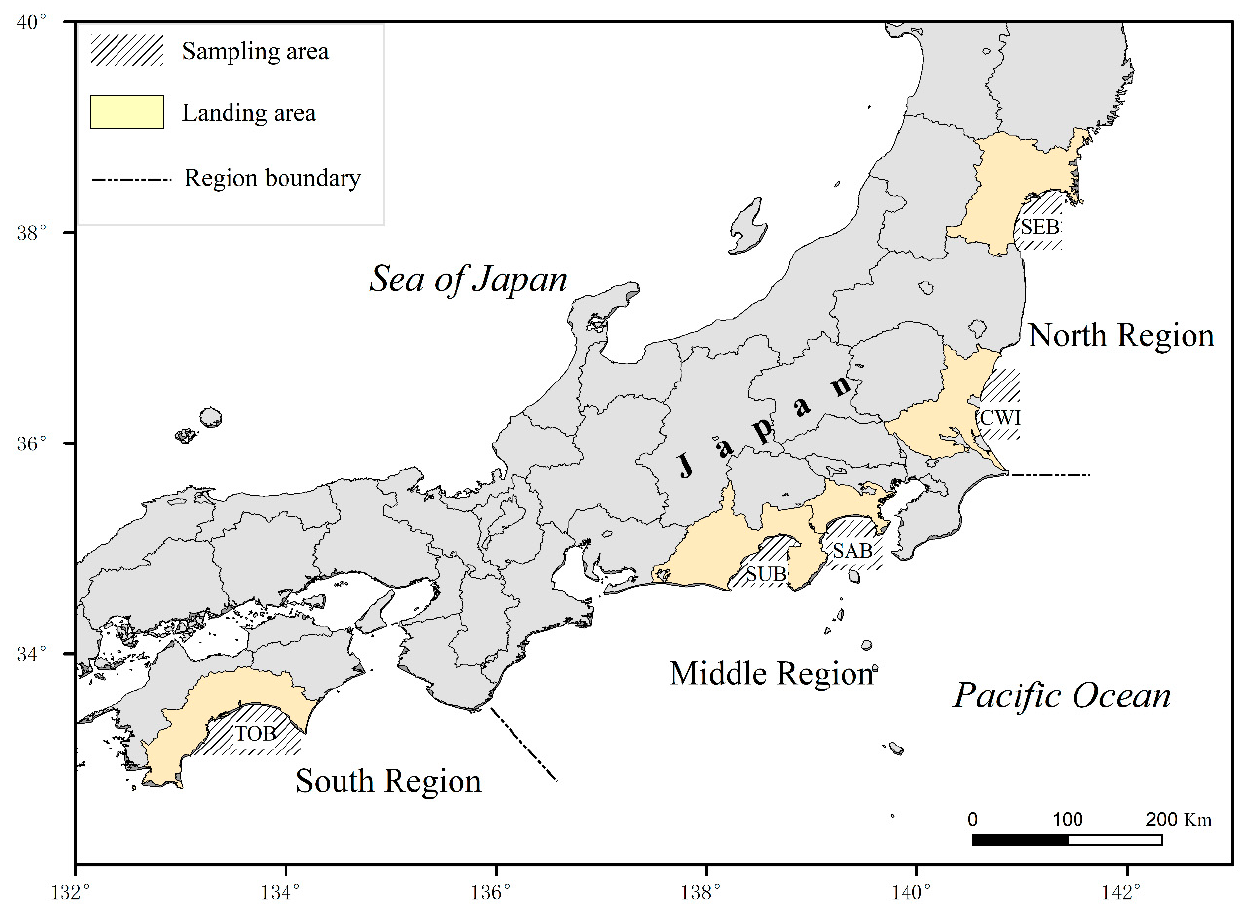
Figure 1. Sampling areas for Japanese anchovy larvae and juveniles.